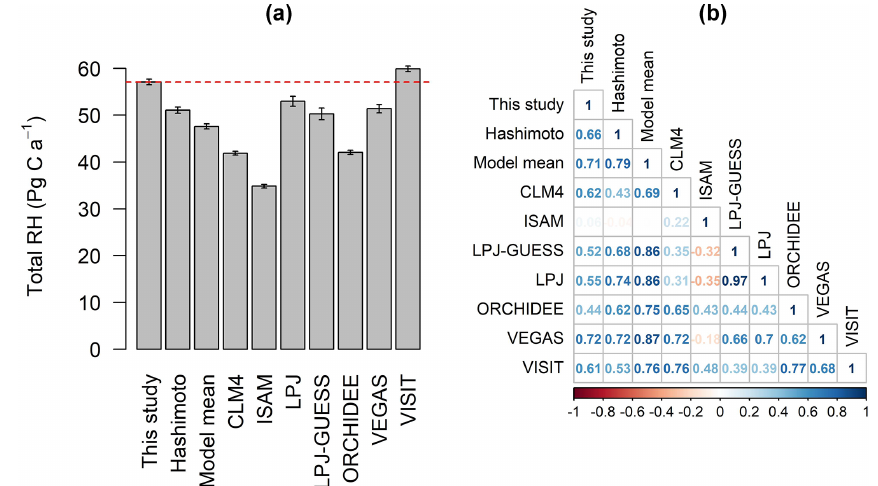
Figure 5. (a) Total global heterotrophic respiration (RH, mean ± standard deviation of annual RH from 1981 to 2010) fluxes and (b) the correlation coefficient analyzed by Pearson correlation between data-derived RH and TRENDY–Hashimoto RH. The dashed red line in (a) represents the average of data-derived RH from 1981 to 2010.